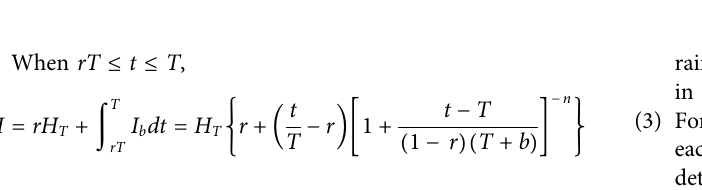
Frontiers in Environmental Science |